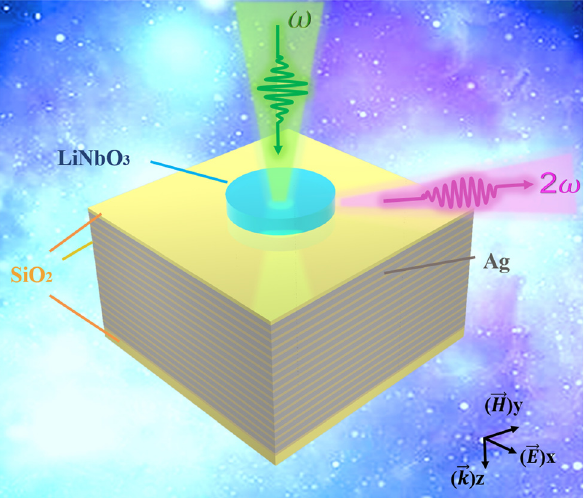
Figure 1: Schematic depiction of the proposed nanostructure for generating SH. The nanostructure consists of three parts: LN nanodisk on the top, HMM at the bottom consisting of 16 bilayers of alternatingsilver(Ag)[24]andsilicondioxide(SiO 2 )[16]layersanda SiO 2 spacer layer with particular designed thickness sandwiched between LN nanodisk and HMM. The nanostructure lies on a glass → substrate. The vector k represents the wave vector of the incident → light and E indicates the x -polarized incident fi